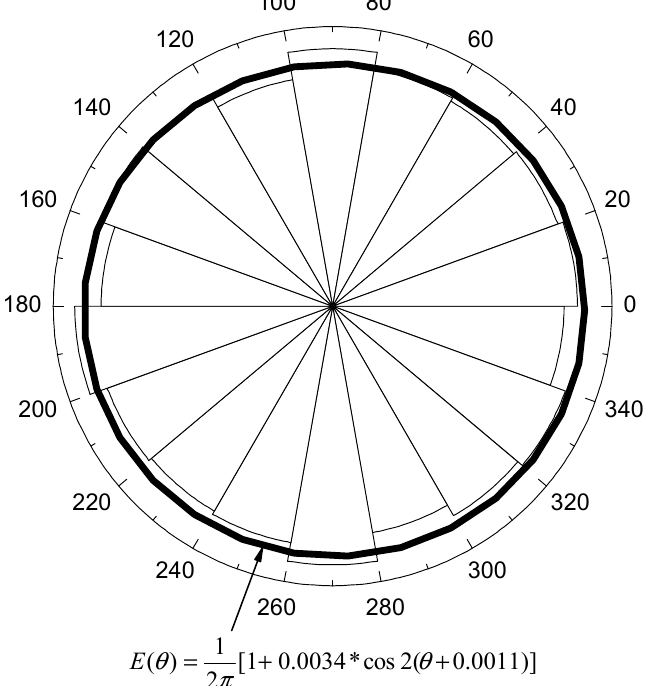
Figure 5. The biaxial sample with rigid top and bottom platens and deformable vertical boundaries.